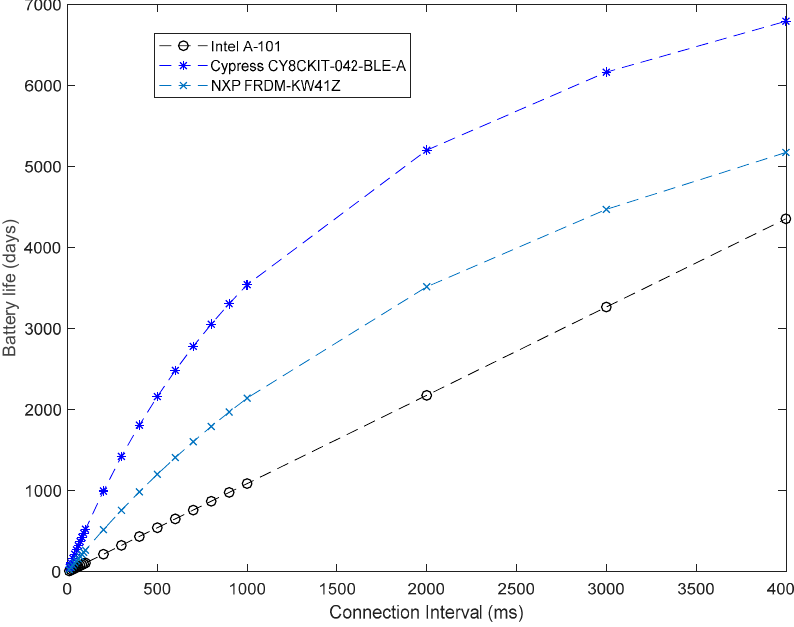
Figure 6. Connection interval vs. battery life in CD mode.